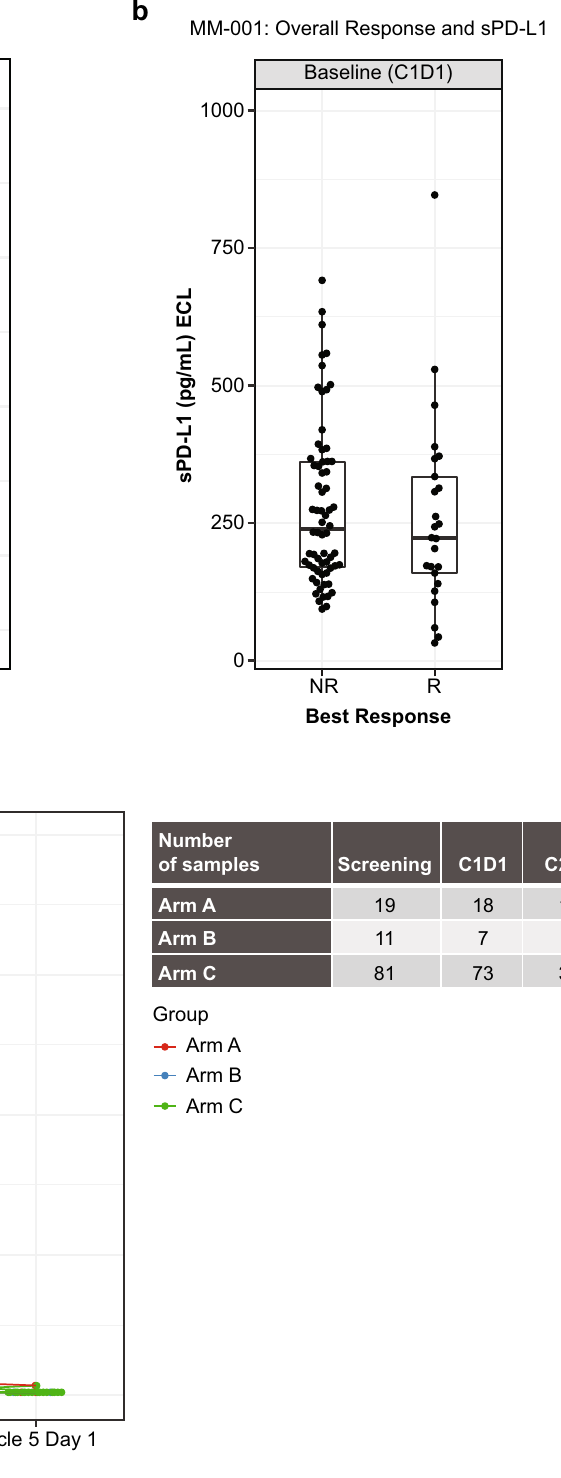
Figure 1. sPD-L1 concentration measured using a quantitative electrochemiluminescence assay: ( a ) sPD-L1 is significantly elevated in RR MM compared with healthy volunteers ( P = 0.0005); ( b ) sPD-L1 at screening does not correlate with response to durvalumab; R, n = 25; NR, n = 66; ( c ) sPD-L1 levels were below the limit of quantitation after treatment with durvalumab. C1D1, cycle 1 day 1; C2D1, cycle 2 day 1; ECL, enhanced chemiluminescent; NR, nonresponders; R, responders; RR MM, relapsed refractory multiple myeloma; sPD-L1, Soluble